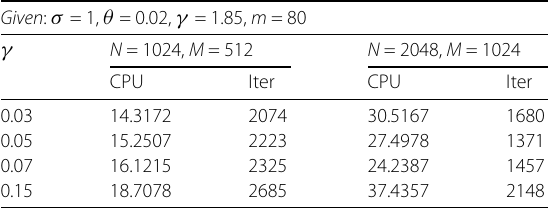
Table 5 The convergence of Algorithm 3.1 with different δ Given : σ = 1, θ = 0.02, γ = 1.85, m =